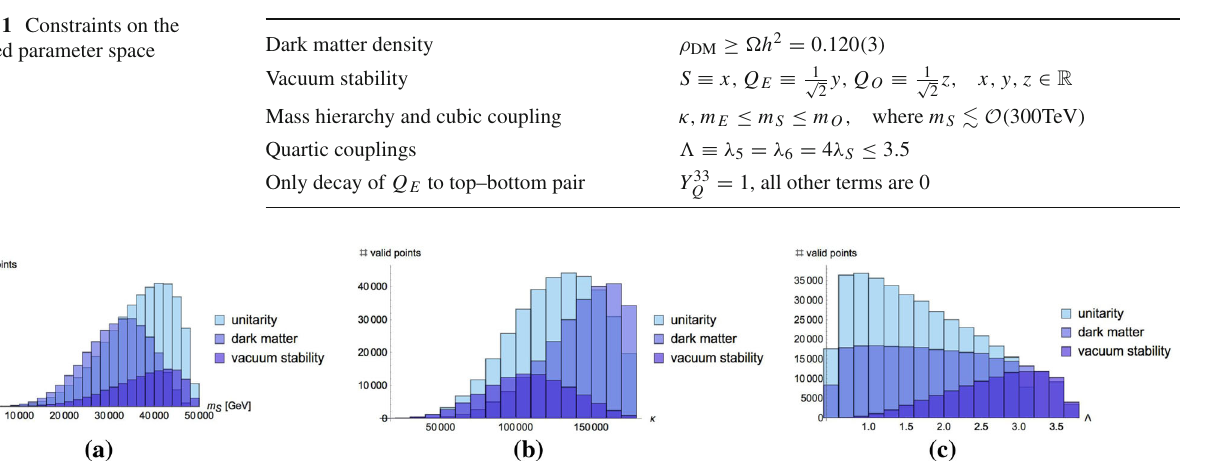
scan points made it through each cut, respectively. In contrast to Fig. 1, these plots do not contain any information about which points make it through two or more